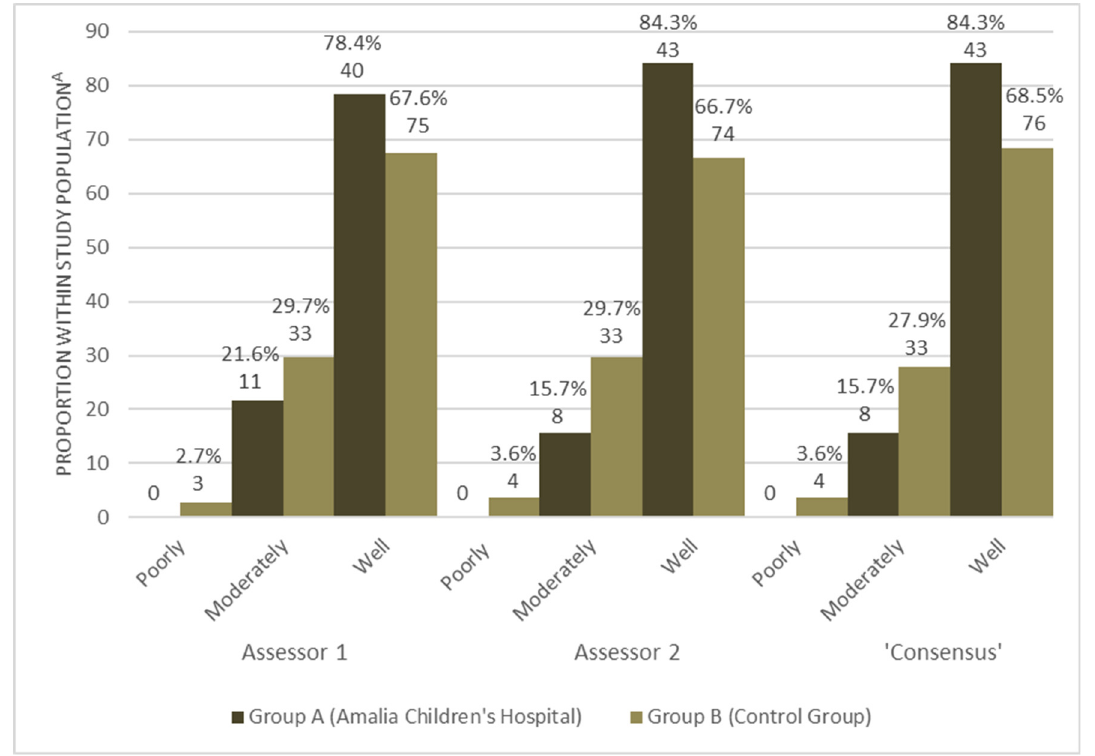
Figure 3. ClinDoc results: overview of the proportion of reports in each category for Group A and Group B separately. Total percentage of reports within the three categories (well, moderately, or poorly); the total absolute number of reports in the category is noted below the percentage.